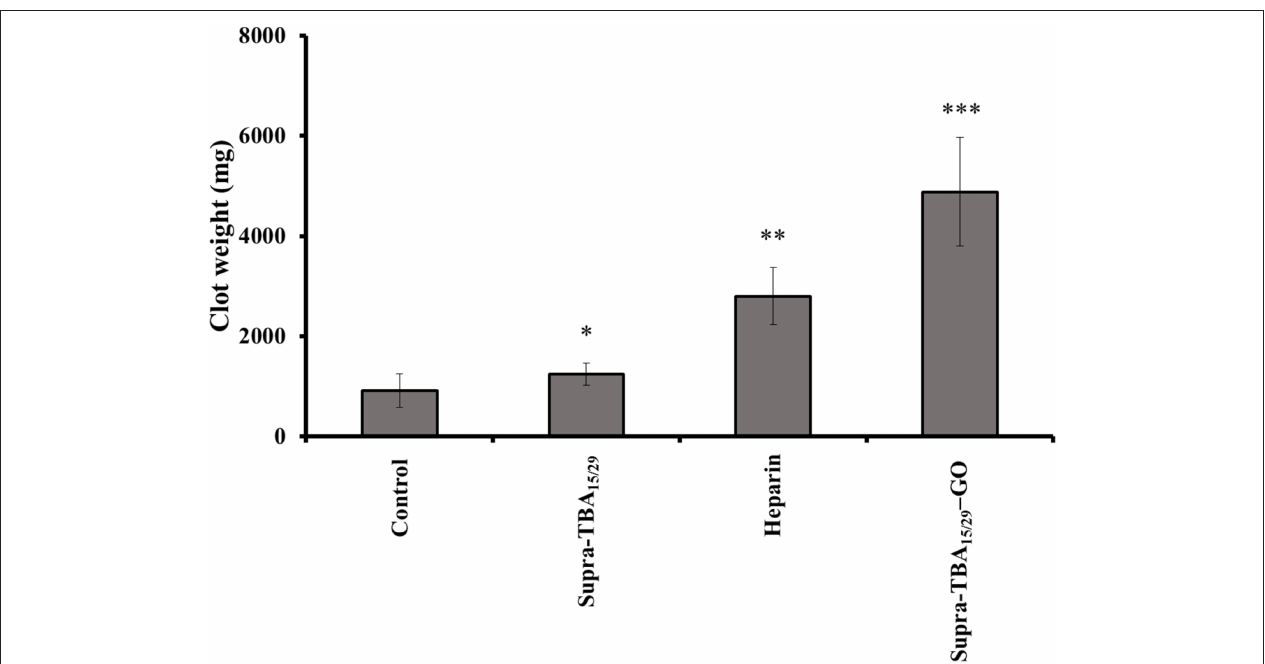
FIGURE 5 | The effect of Supra-TBA 15 / 29 , heparin, and Supra-TBA 15 / 29 -GO on rat-tail bleeding. Blood clots were collected after intravenous administration of the inhibitors (2.0 µ M, 100 µ L). Error bars represent the standard deviations of experiments in five rats. An asterisk indicates statistically significant differences (* P < 0.05, ** P < 0.01, *** P < 0.001; n = 5) as compared with the control